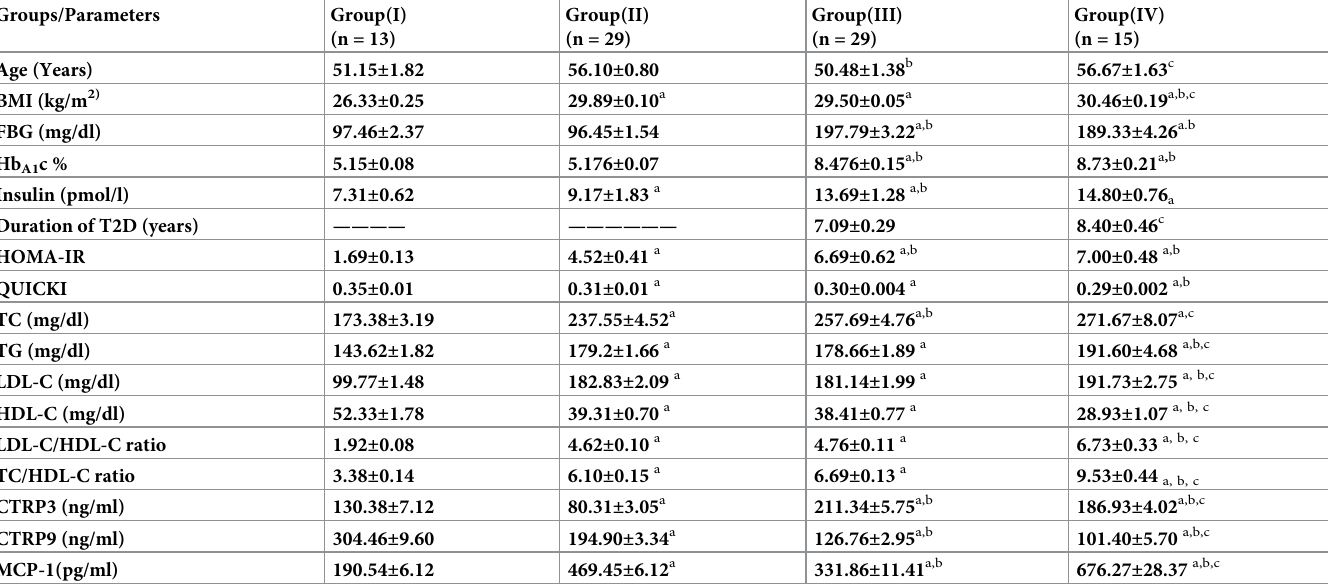
Table 1. Clinical and laboratory characteristics of the studied